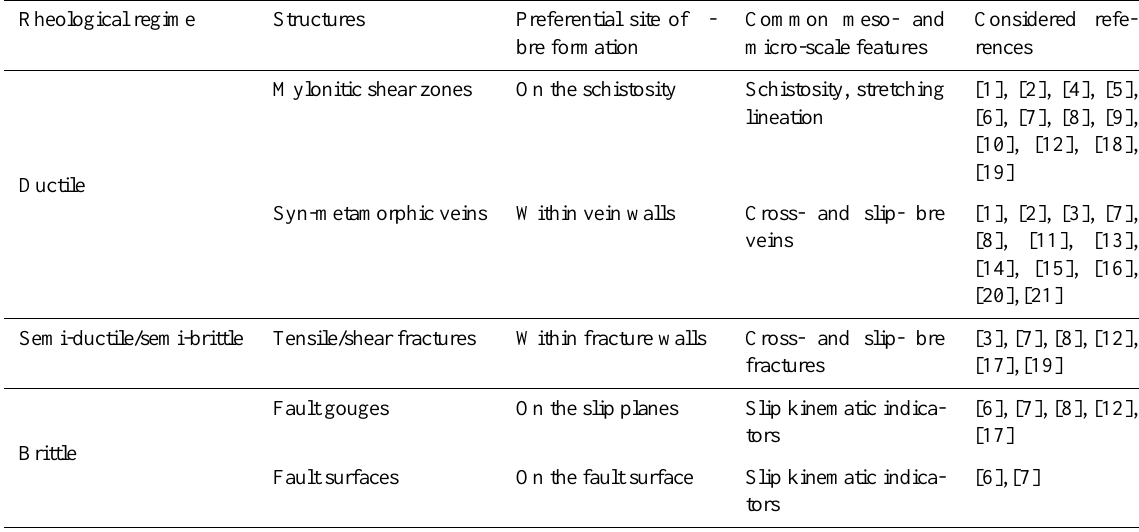
Table 1. Summary of the deformation fabrics hosting fibres in